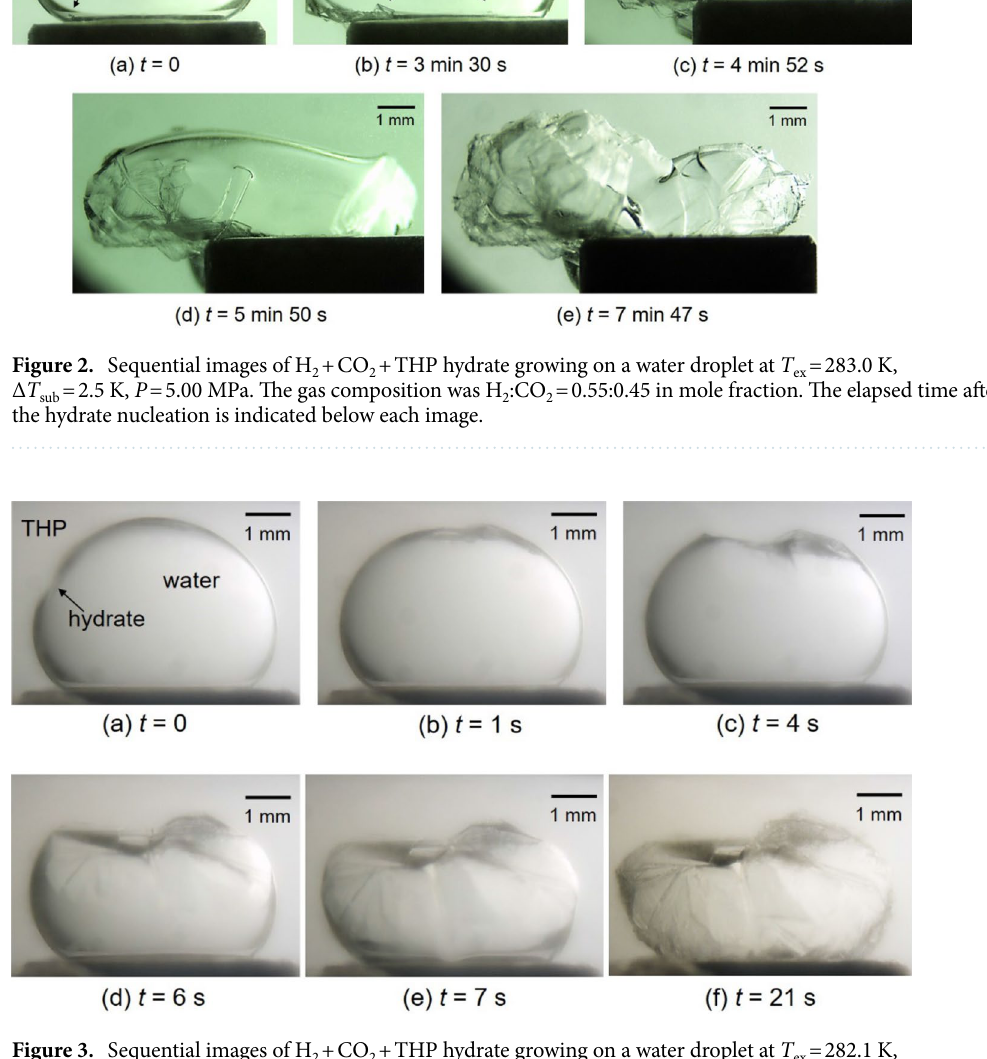
Figure 3. Sequential images of H 2 + CO 2 + THP hydrate growing on a water droplet at T ex = 282.1 K, Δ T sub = 4.5 K, P = 4.95 MPa. The gas composition was H 2 :CO 2 = 0.55:0.45 in mole fraction. The elapsed time after the hydrate nucleation is indicated below each